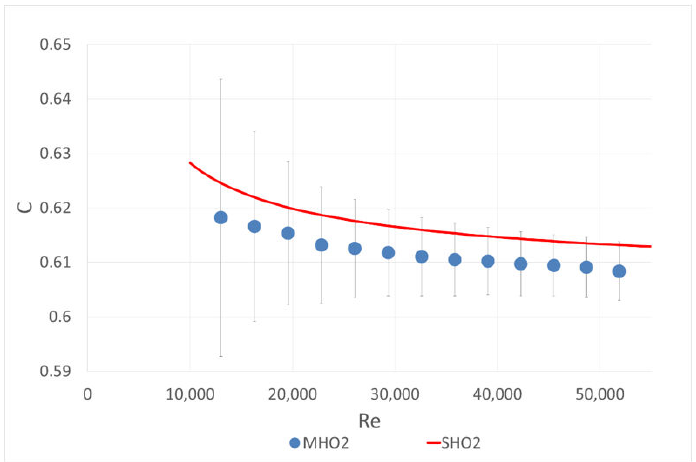
Figure 4. Comparison of flow coe ffi cients for the single-hole orifice SHO1 and multi-hole orifice MHO1 of the same contraction coe ffi cient β = 0.5164.